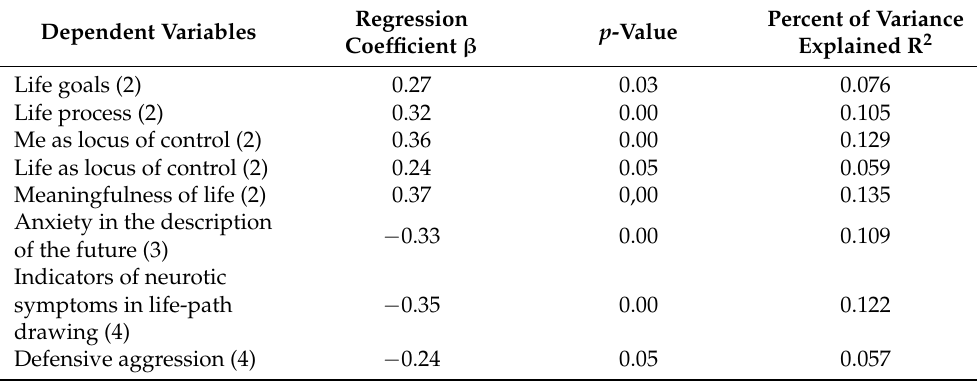
Table 4. Data on predicting the indicators of psycho-emotional health by separation type in middle- aged women ( n =